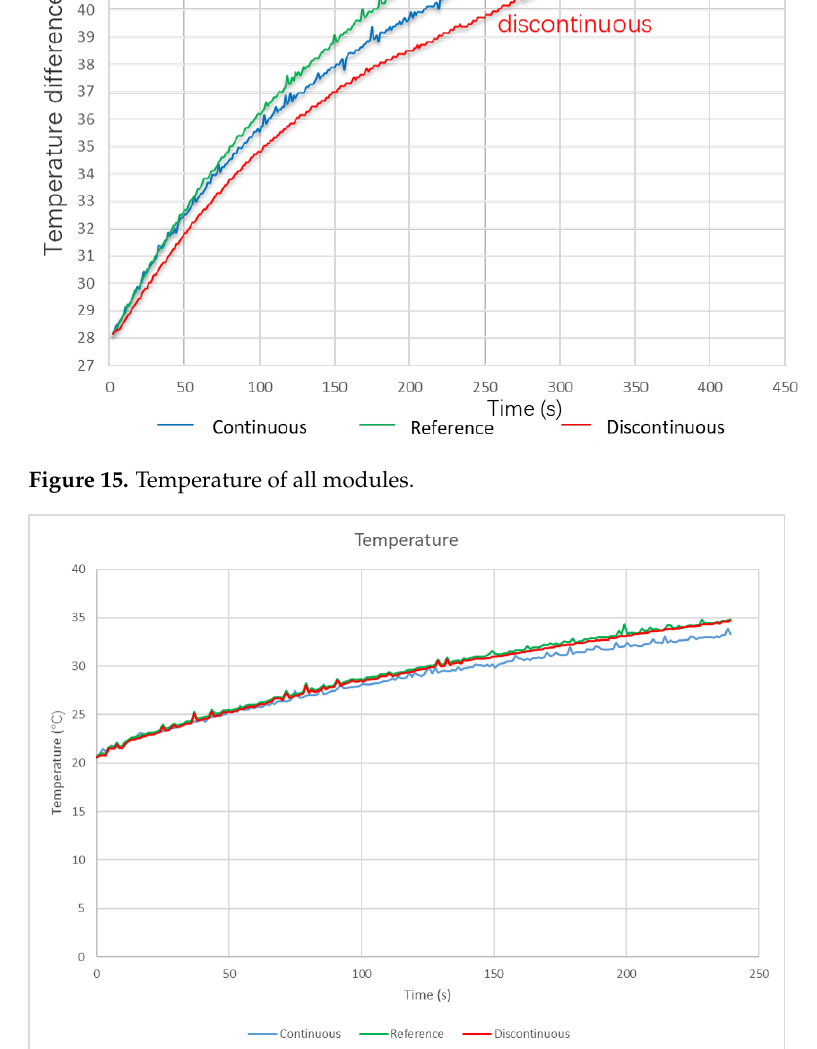
Figure 16. Temperature of all modules with all valves turning